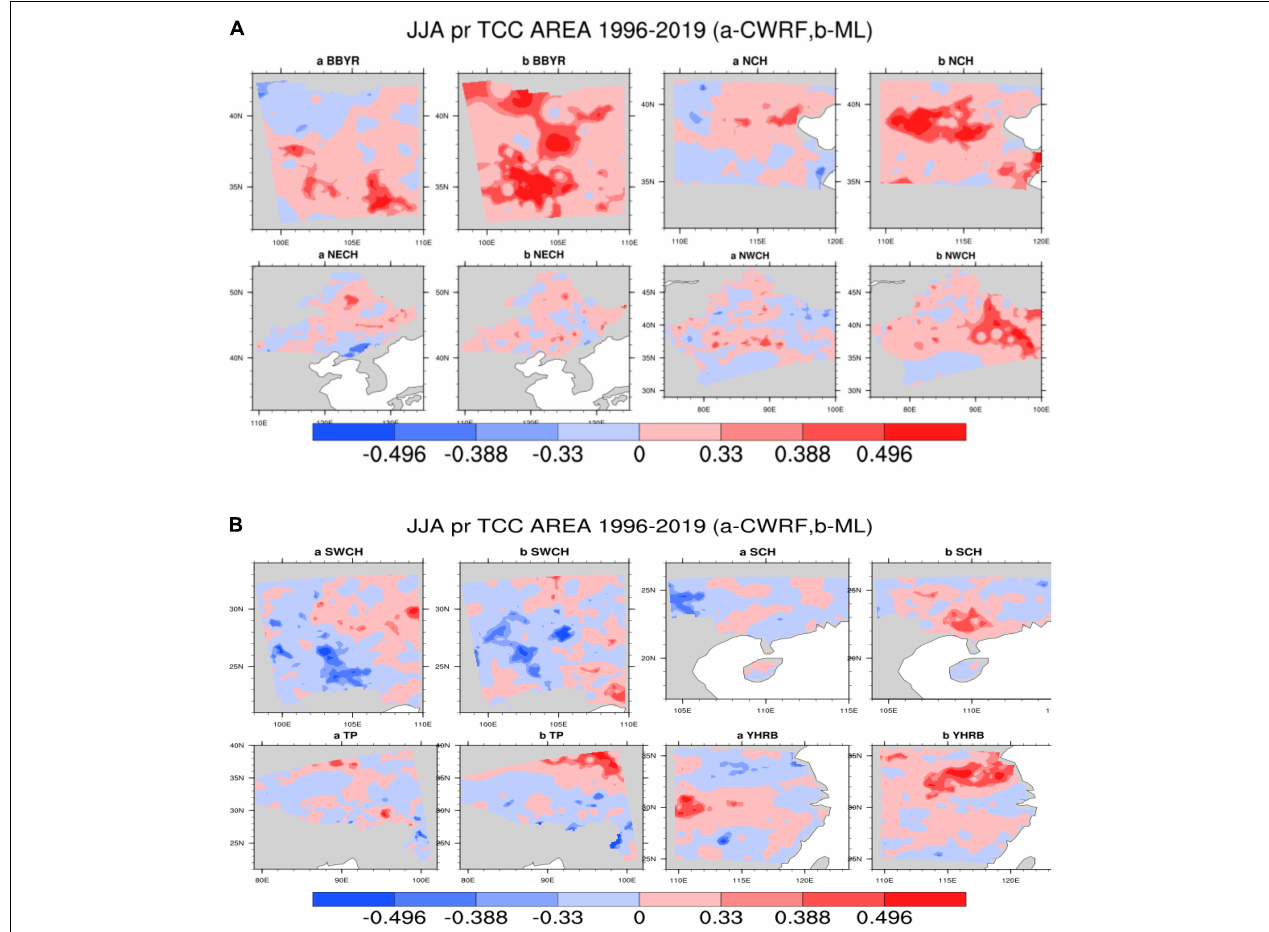
FIGURE 5 | (A) Comparison of regional precipitation time correlation coefficients [Climate-Weather Research and Forecasting (CWRF) vs. Machine Learning (ML)], the color code numbers 0.33, 0.388, and 0.496, respectively, represent that the correlation coefficients have passed the significance test of 90%, 95%, and 99%, respectively. (B) Comparison of regional precipitation time correlation coefficients (CWRF vs. ML); the color code numbers are the same as panel (A)